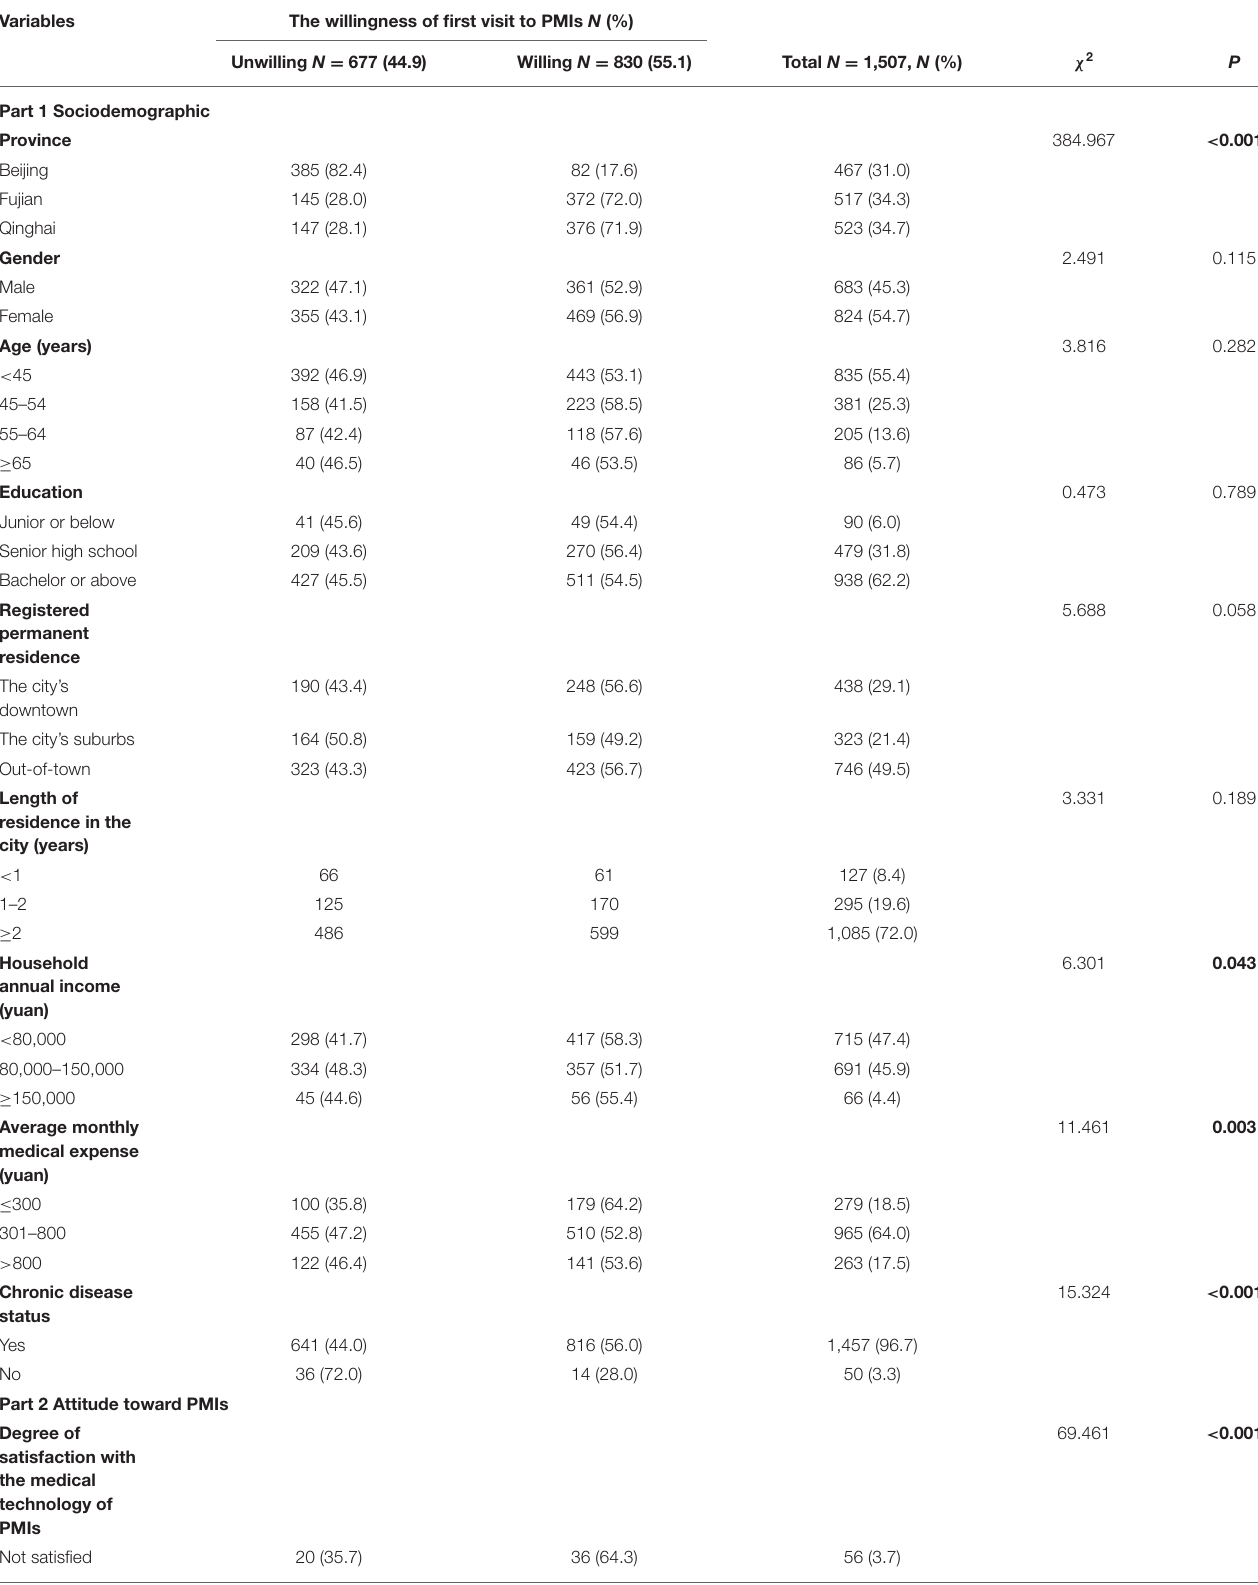
TABLE 1 | Patients’ sociodemographic characteristics and univariate analysis of patients’ willingness of first visit in PMIs.